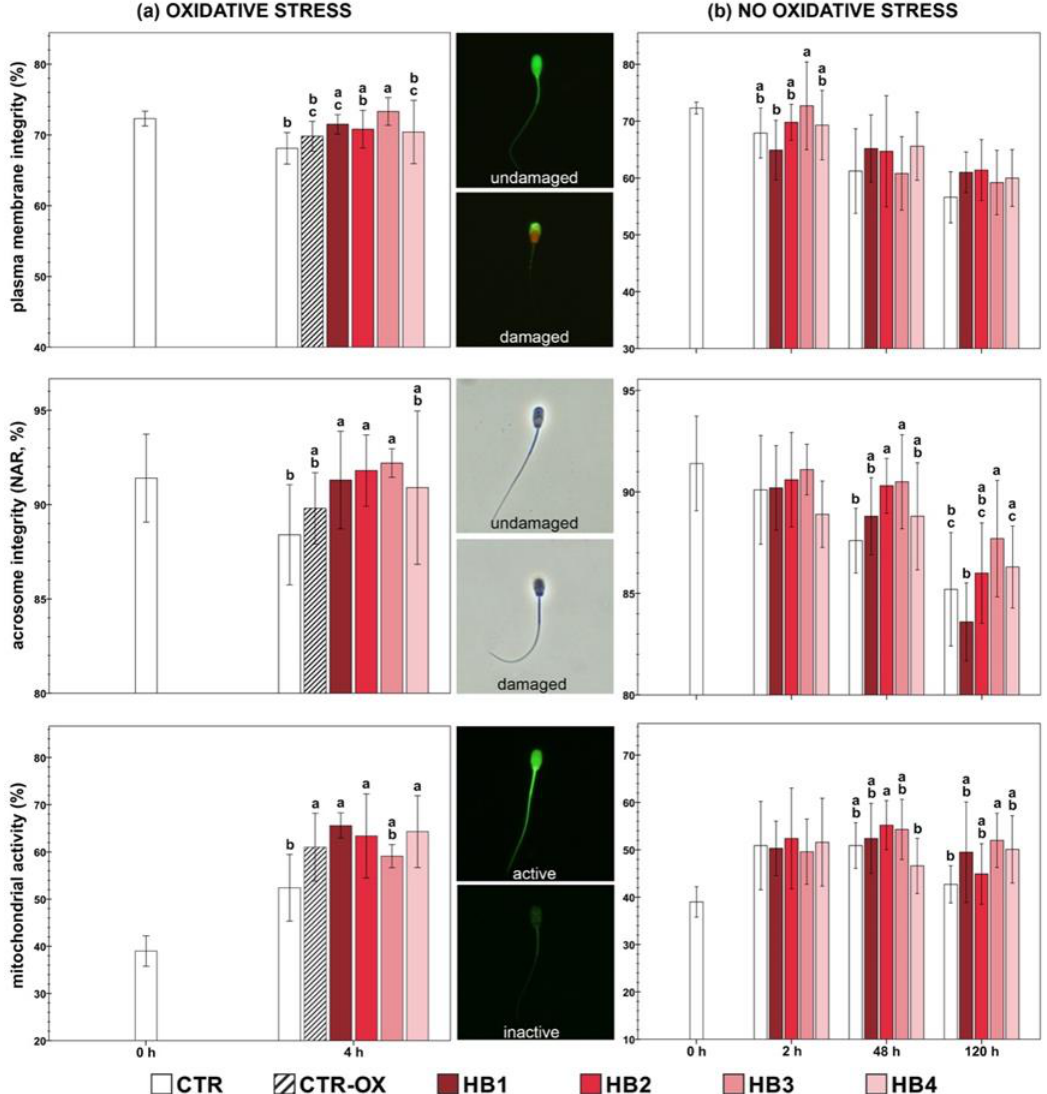
Figure 2. Effect of honeybush extract on the plasma membrane integrity, acrosome integrity, and mitochondrial activity of boar sperm under induced oxidative stress ( a ) and during semen storage without oxidative stress ( b ). Different letters indicate significant differences between treatments within each given time ( p < 0.05). CTR = control samples without oxidative stress; CTR-OX = control samples under induced oxidative stress; HB = honeybush; Treatments = HB1 (200 µg/mL); HB2 (50 µg/mL); HB3 (12.5 µg/mL); HB4 (3.125 µg/mL). The data are shown as the mean ± standard deviation of five replicates.